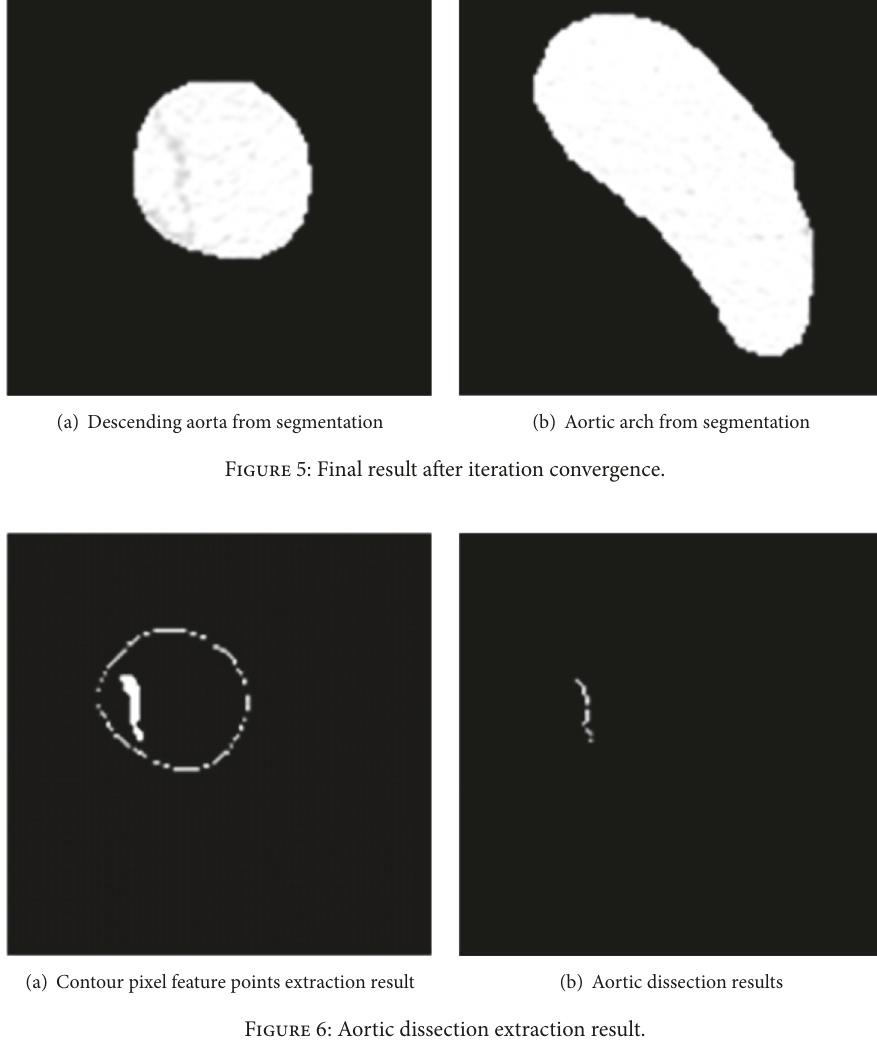
Figure 6: Aortic dissection extraction